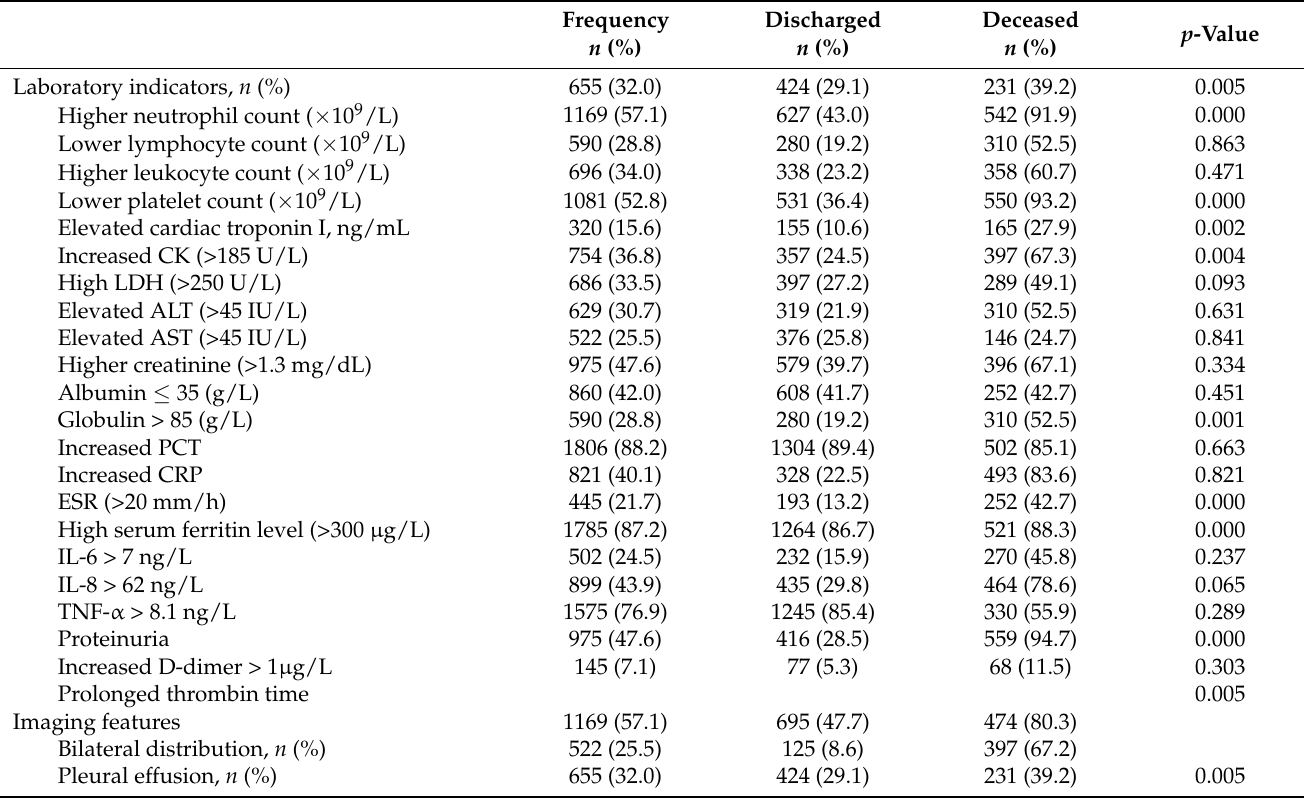
Table 2. Laboratory and radiological indicators of COVID-19 patients and in-hospital